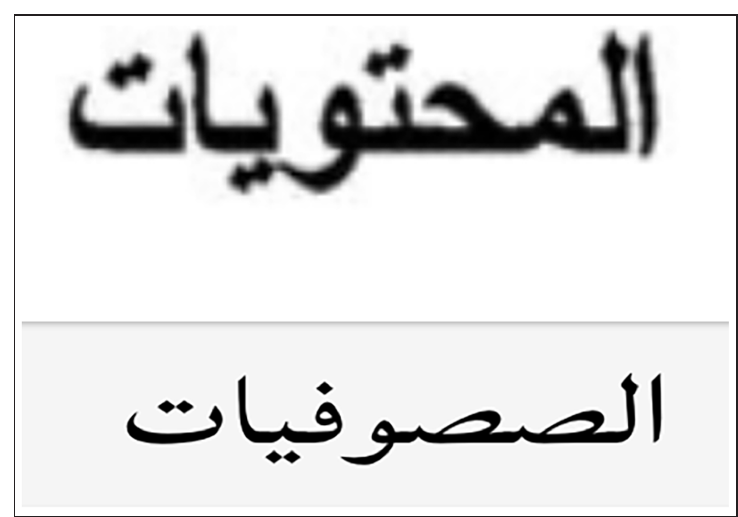
Figure 7: Bolded and enlarged text size header and poor